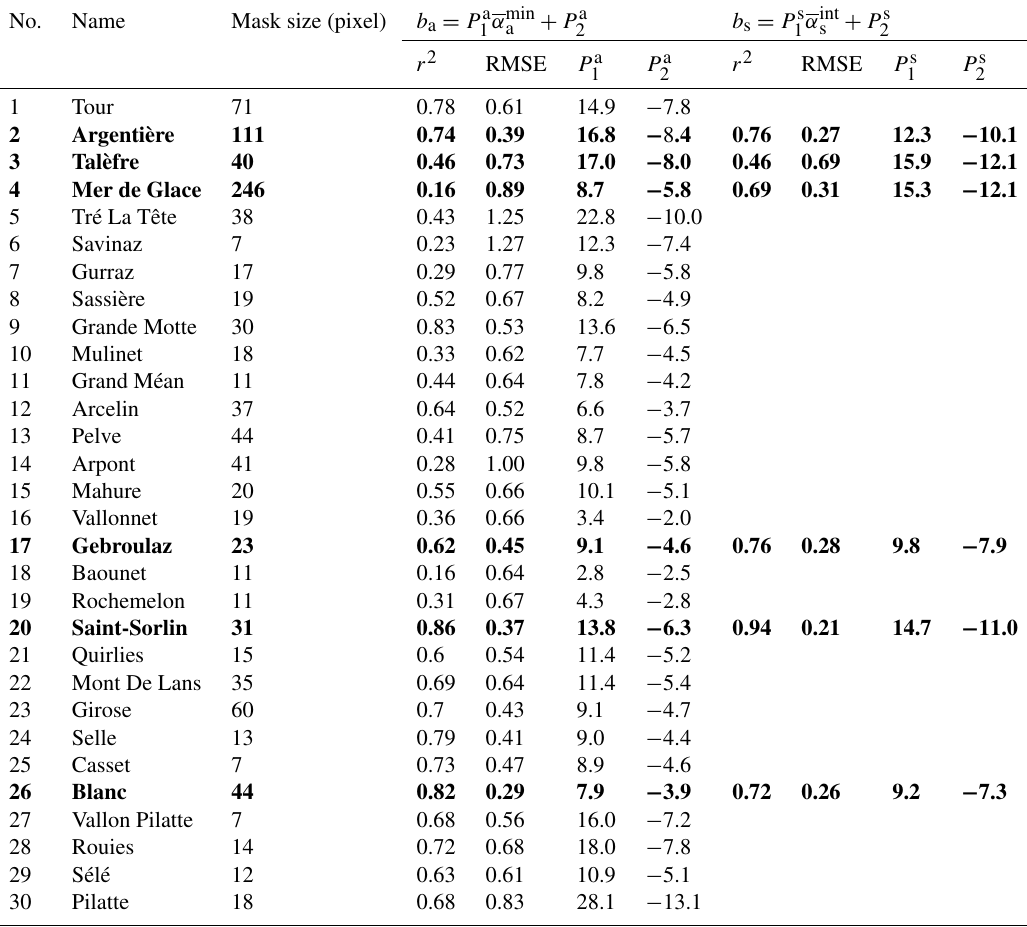
Table 1. List of studied glaciers, characteristics and albedo/mass balance correlations over 2000–2015, except for summer coefficients (over 2000–2010). For localization, refer to Fig. 1. Bolded rows exhibit glaciers where annual and summer in situ glacier-wide SMB data are available. The mask size is expressed in number of pixels. To obtain the glacier mask area in km 2 , one should multiply the mask size by 0.0625km 2 . Determination coefficients are expressed for each glacier. Note the units of r 2 (%), RMSE, P 1 and P 2 (mw . e . ).